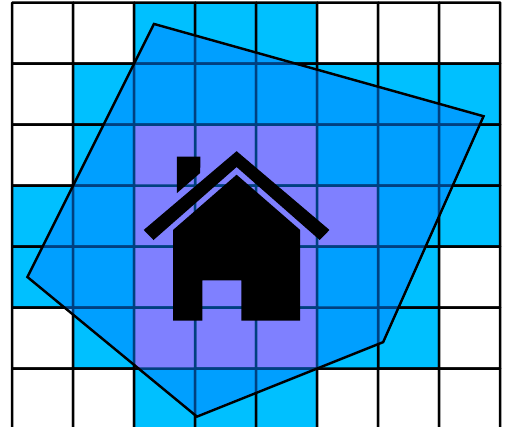
Figure 4. The projected limit check uses a grid structure in order to determine the degree of occupancy on a property (white: nonproperty; blue: nonbuilt-up property; and purple: built-up property). Using a sufficiently high resolution, e.g., one square centimeter per cell, this method does not require complicated geometric intersection operations, and thus it is numerically